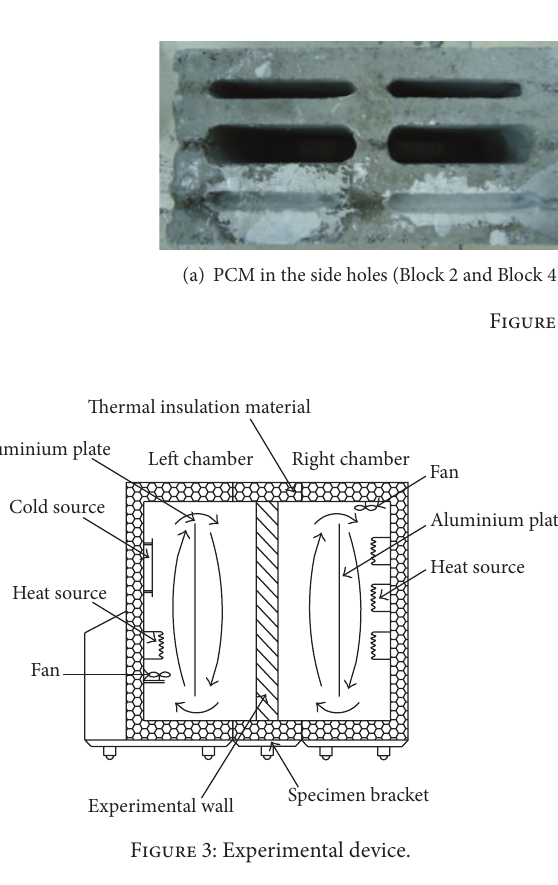
Figure 1: Schematic diagram of the PCM’s positions in the blocks.